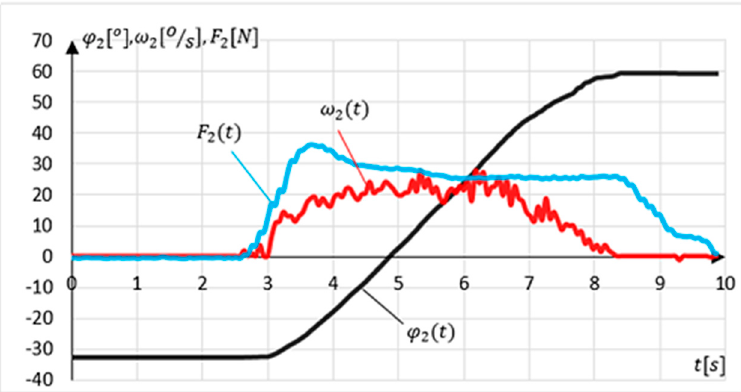
Figure 19. Result of the first experiment-achieving maximum dorsiflexion ϕ 2 = 60°. Another experiment involved examining the intention to change the movement direction (relapse procedure). The experiment lasted 10 s. The device position was set at maximal dorsiflexion. The exercising person’s task was to make two changes in the direction of movement followed by a return to the starting position. The results of the experiment are shown in Figure 20.